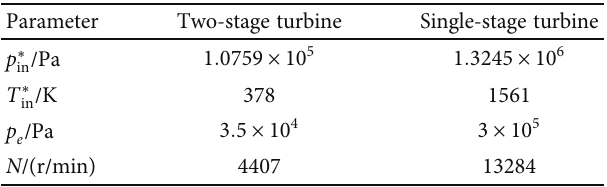
Figure 7: Turbine fl ow path and Q3D grid: (a) two-stage turbine; (b) single-stage turbine. Table 1: Turbine design parameters.